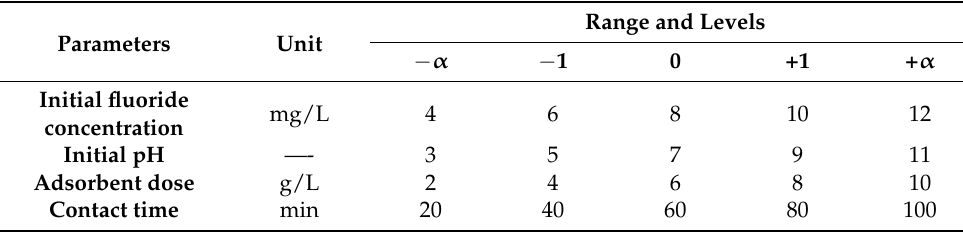
Table 1. Levels of independent parameters and their coded values for the CCD